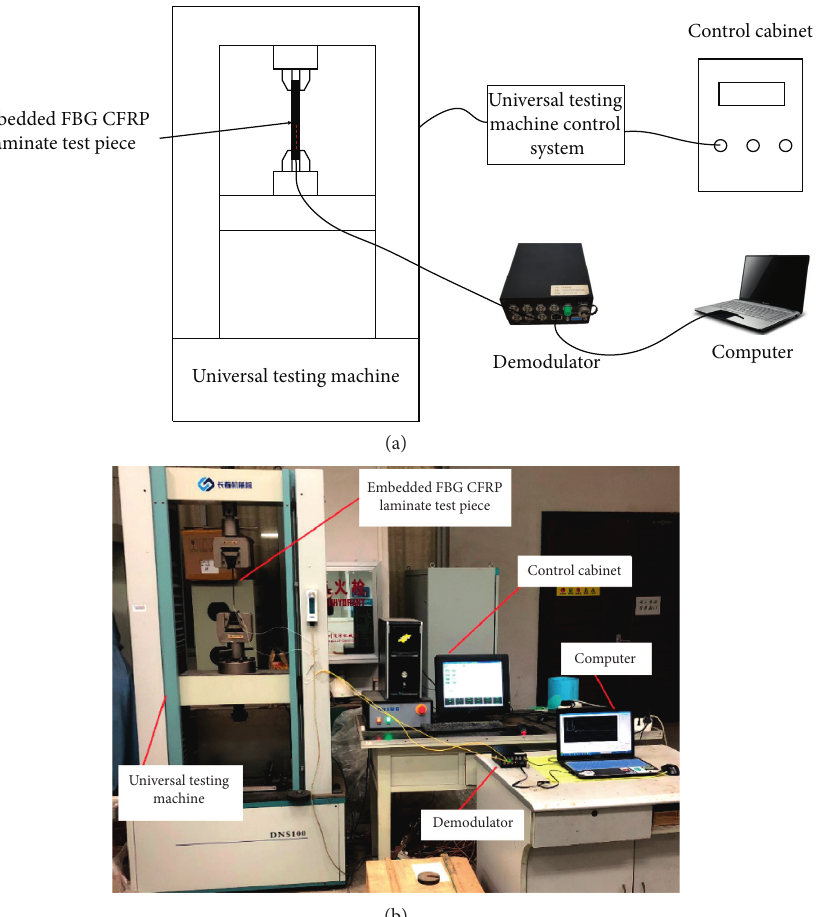
Figure 12: Experimental system. (a) Schematic diagram of the experimental system. (b) Material diagram of the experimental